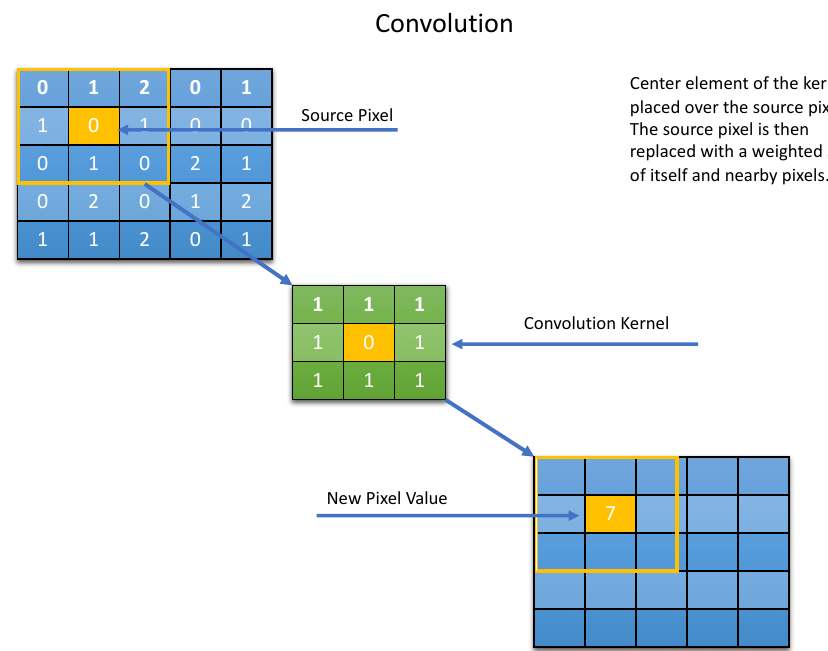
Figure 5. Above, the so-called convolutional layer is broken down into its elementary components. CNN models have another layer, known as the fully connected layer; although not a CNN characteristic, this layer produces input vectors using appropriate linear combinations and activation functions. This layer is known for the classification of input images into the network. It calculates probabilities by multiplying elements by specific weights to make sums. An activation function defined as (logistic if N = 2, Soft-Max if N > 2) is then applied. This is similar to the multiplication of the input vector by the weight matrix. The way that the CNN learns, convolutional layer filter via back-propagation gradient, is similar to learning weight values. This concept can be applied in the evaluation of the model. The curve for the Re-Lu activation function is shown in Figure